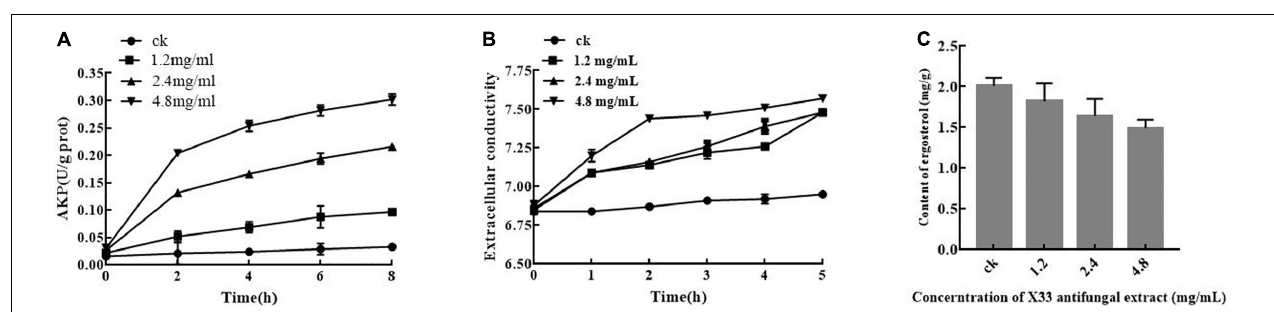
FIGURE 5 | Effects of X33 antifungal extract incubation on cell integrity of P. digitatum . (A) Extracellular conductivity. (B) Alkaline phosphatase activity of P. digitatum . (C) Ergosterol